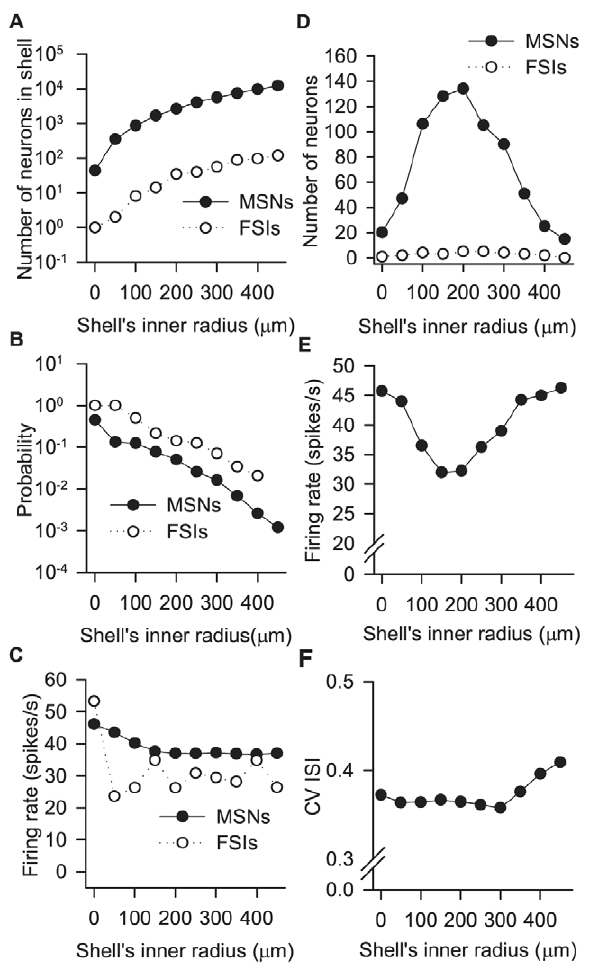
Figure 10. Implications of distance-dependent connections for MSN output. We stimulated all neurons within a 50 m m wide spherical shell at varying distances from the centre of a 1mm-on-the-side cube of striatum (84900 MSNs, 1% FSIs) and studied the effect on the centre MSN’s activity. A The total number of neurons per shell increases exponentially with increasing distance from the centre; here and in other panels we plot distances as the inner radius of the shell. B The probability of any chosen neuron in that shell contacting the central MSN falls exponentially with increasing distance. As contact probabil- ities are symmetric, this can also be read as approximately the distribution of probabilities for the central MSN contacting a given neuron in that shell. C All stimulated neurons received approximately 1250 spikes/s excitatory input for 4 seconds. The mean firing rate of MSNs in each shell fell slightly with increasing distance for the first few shells; the mean firing rate of FSIs in the shell was roughly constant (the first shell contained only one FSI). D The number of neurons projecting to the centre MSN peaked at the same distance for both MSN and FSI afferents, and confirm that the mean distances predicted by the network model (Table 5) do correspond to the distances of the greatest number of inputs. E In response to the same input as the stimulated neurons, the centre MSN’s firing rate follows the inverse of the distribution of its inputs across the shells. F The centre MSN’s inter- spike interval (ISI) coefficient of variation (CV), indicating the irregularity of the spike train, was also modulated by the distance of the afferent input. currently a prediction of the model. By contrast, we found that the density of FSI gap junctions was captured by the model using passive intersections of dendrites alone.